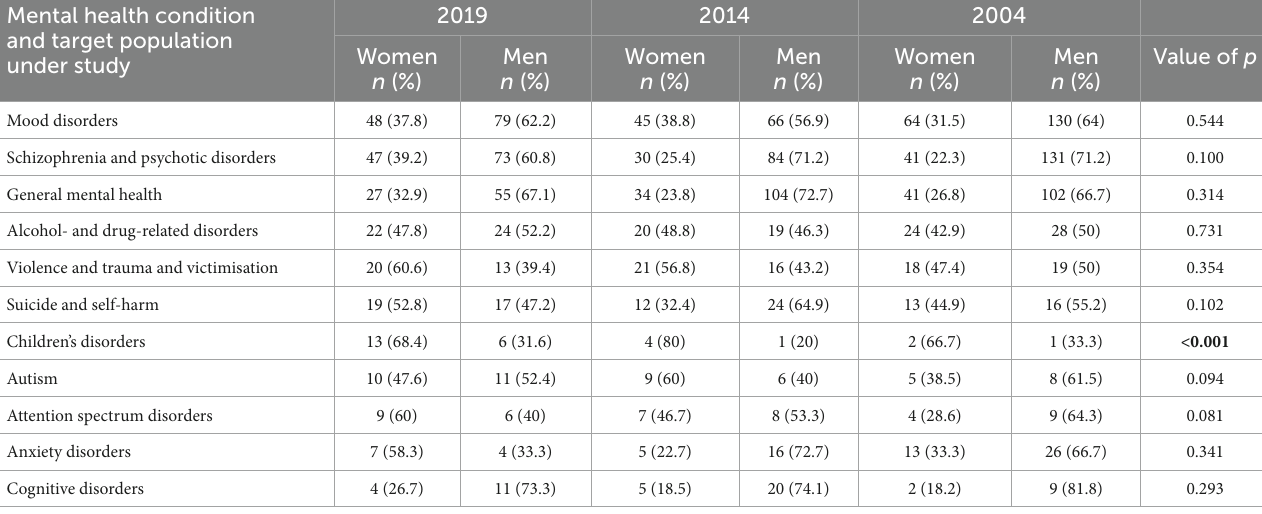
TABLE 1 Number of female and male first authors of articles by mental health condition and target population under study in 2004, 2014 and